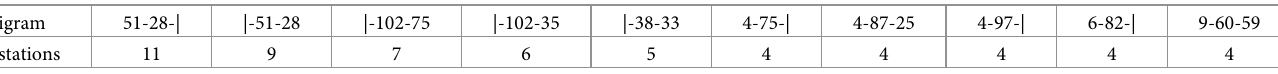
Table 2. Number of attestations for the 10 most frequent sign trigrams in the dataset. Trigram